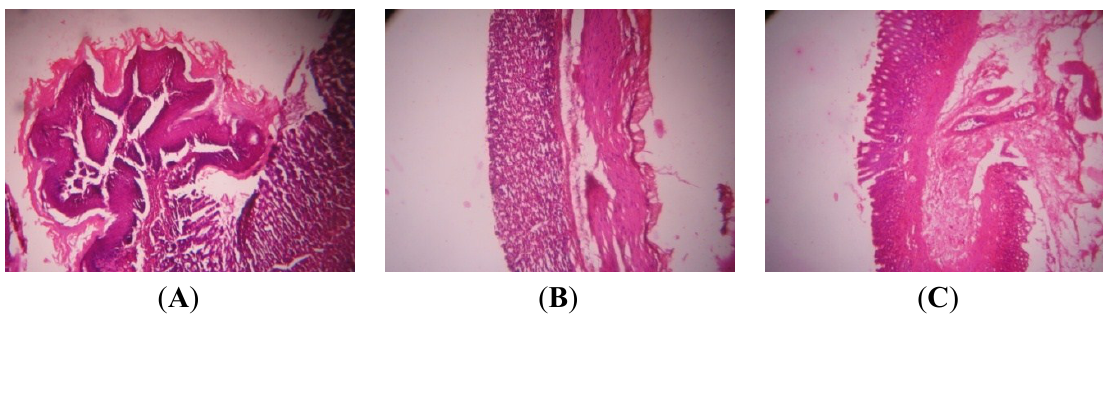
Figure 2. H&E stained cross-sections of mice skin: ( A ) Group I (water + DMBA + croton oil) ( B ) Group II (rutin 200 mg/kg+ DMBA + croton oil) ( C ) (rutin 400 mg/kg+ DMBA + croton